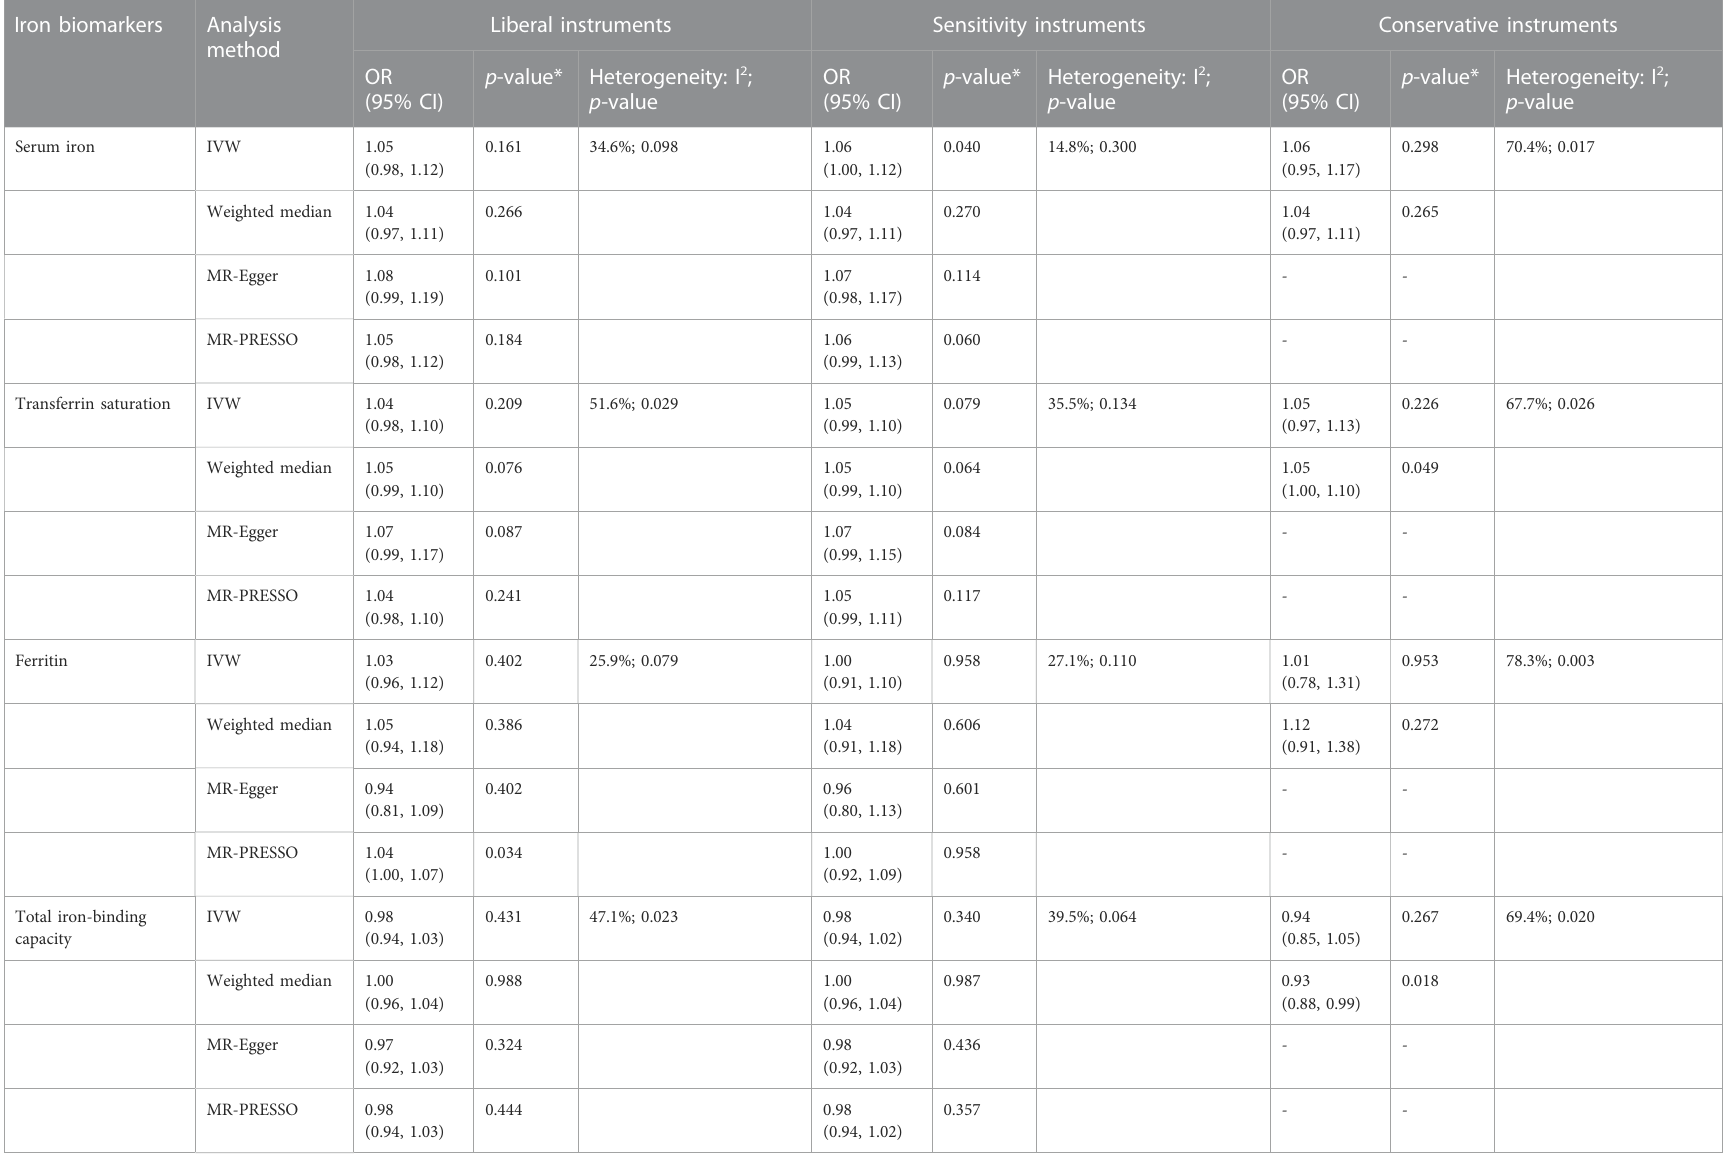
TABLE 1 Associations of the instrumental SNPs with four systemic iron status biomarkers and knee